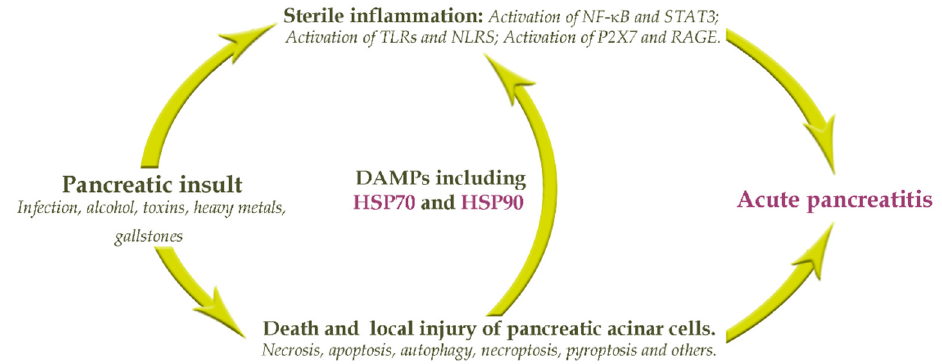
Figure 1. Principal scheme of cascade interactions in development of AP: Activation of nuclear factor- κ B (NF- κ B); mitogen-activated protein kinase (MAPK); signal transducer and activator of transcription 3 (STAT3); toll like receptor (TLR); nod-like receptors (NLRs); purinergic P2X7 receptor; receptor for Advanced Glycation Endproducts (RAGE); and damaged associated molecular patterns (DAMPs) [3].